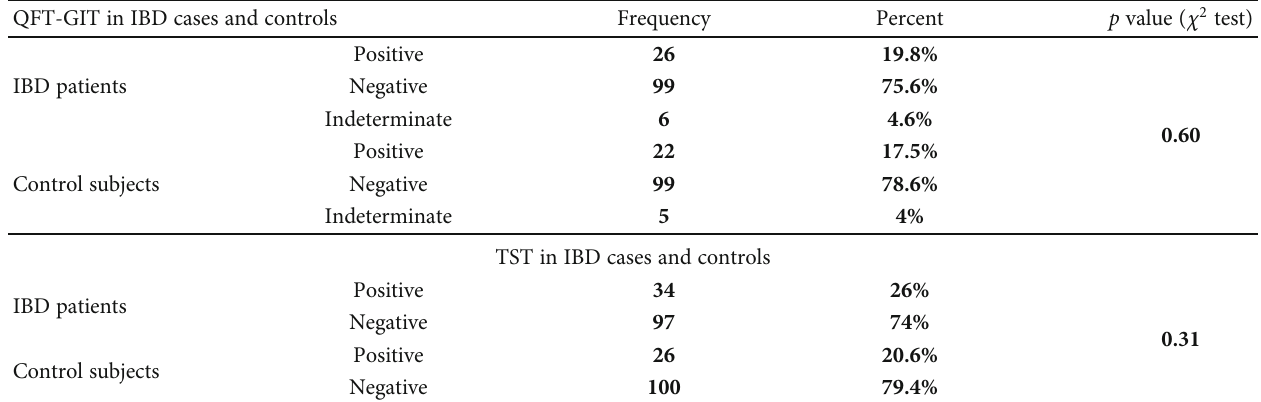
Table 3: Distribution of QFT-GIT and TST in IBD cases and